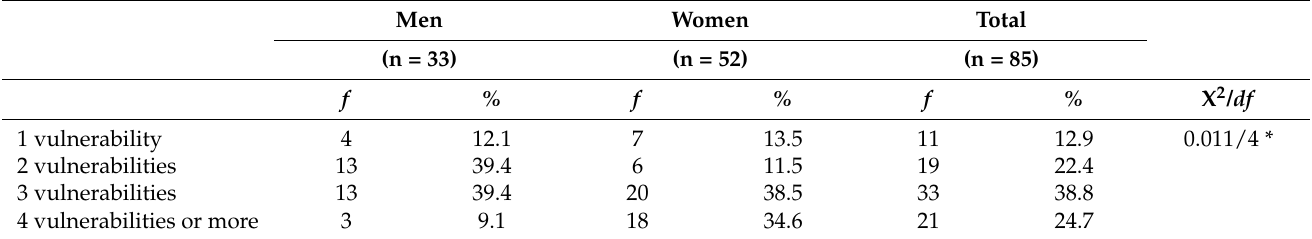
Table 7. Prevalence of anxiety symptoms and accumulated